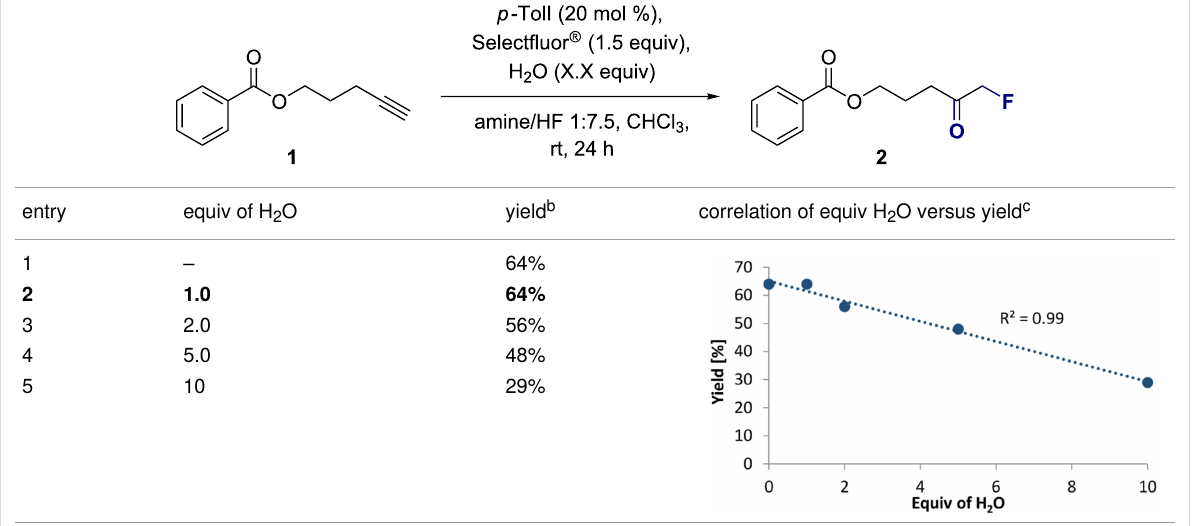
entry equiv of H 2 O yield b correlation of equiv H 2 O versus yield